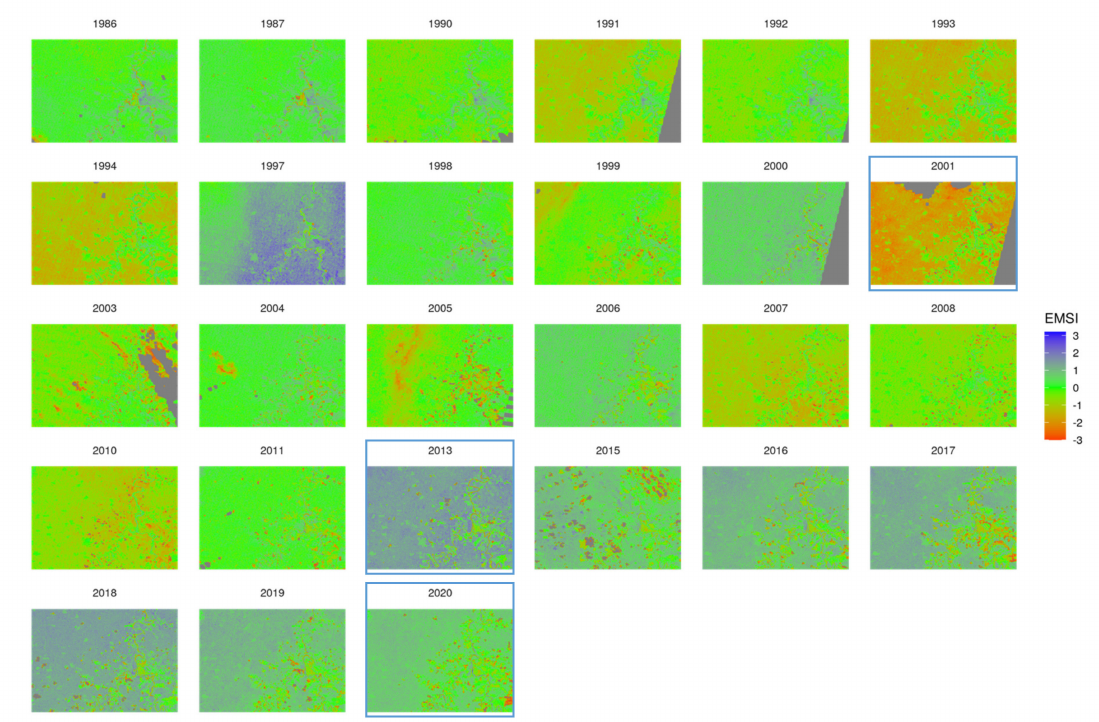
Figure A6. EMSI for 1986-2020 for Landsat 5, 7, and 8 time series for the month of August in Acre state, Brazil. The years 1988, 1989, 1995, 1996, 2002, 2009, 2012, and 2014 had no clear sky scenes. The years 1993, 1993, 2001, 2005, and 2010 were historic drought years in Brazil and appear as highly stressed. The region undergoes rapidly expanding conversion to agriculture in the last decade of the time series. The three years with blue highlighted boxes are shown below in more detail in Figure 10. Pixels with no data due to masking are